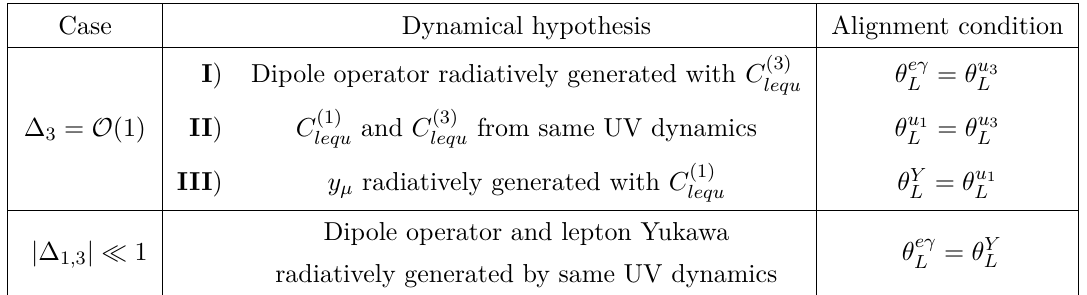
Table 1 . Alignment conditions following from specific dynamical